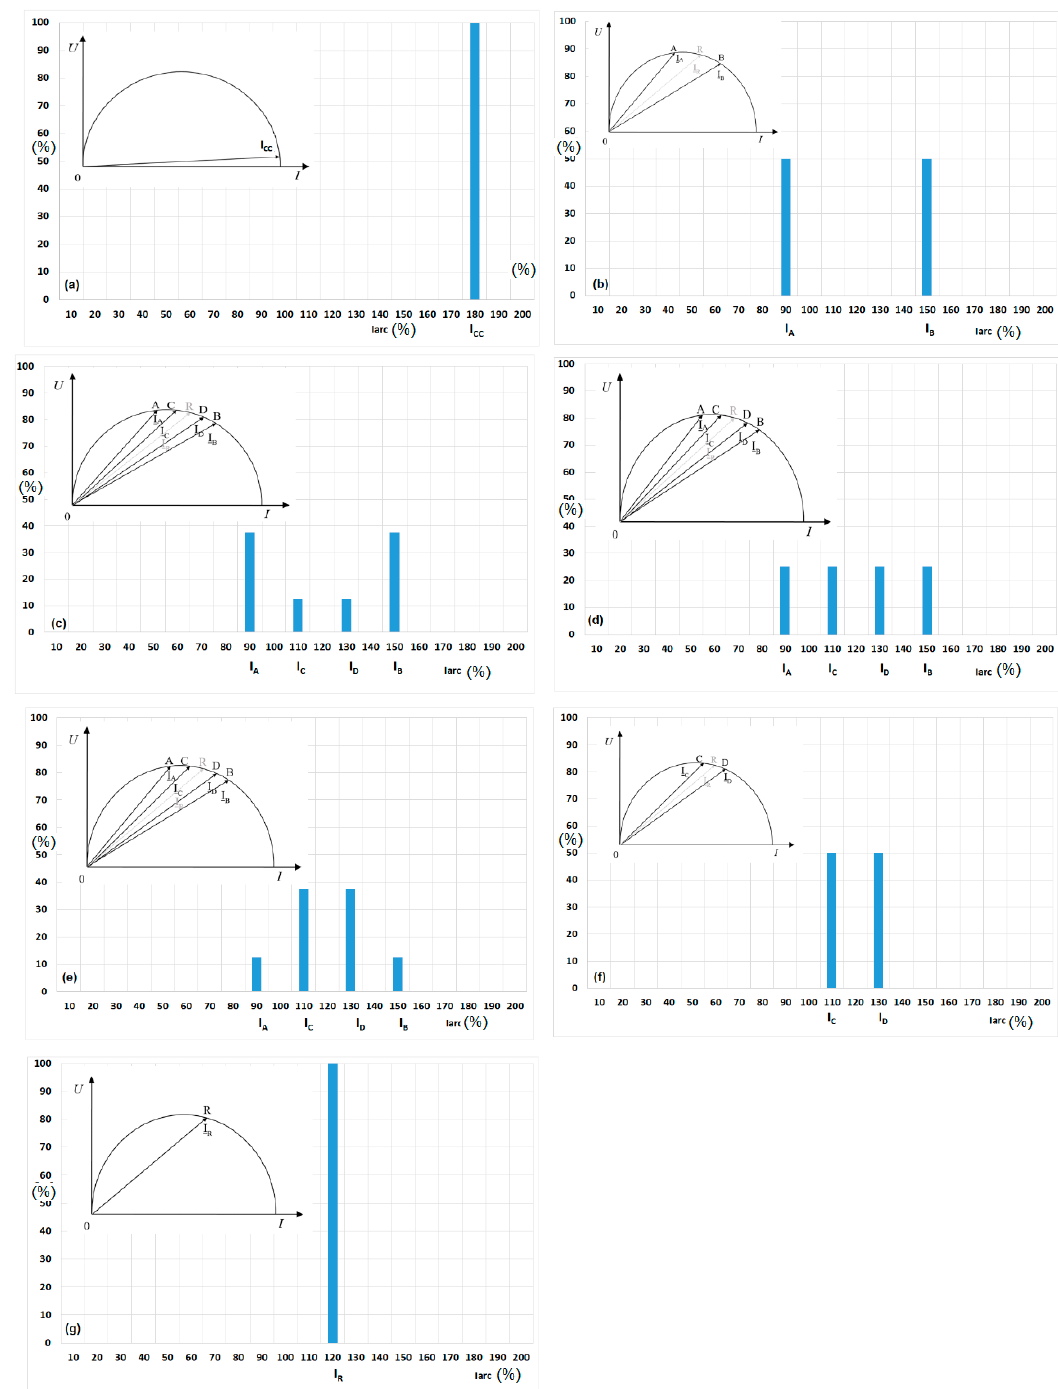
Figure 12. Histograms of furnace current changes: ( a ) electrode short circuit with charge, ( b ) two-state current changes - beginning of melting of scrap metal, ( c-e ) four-state current changes - for various furnace current fluctuations, ( f ) two-state current changes - final stage of melting scrap metal, ( g ) stable operation of the arc furnace.